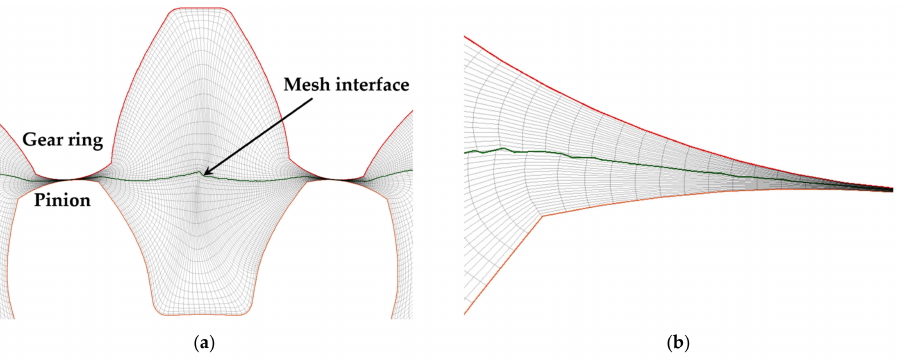
Figure 6. Mesh of the displacement chambers ( a ) and meshing details of the radial gaps ( b ) of the IGP.